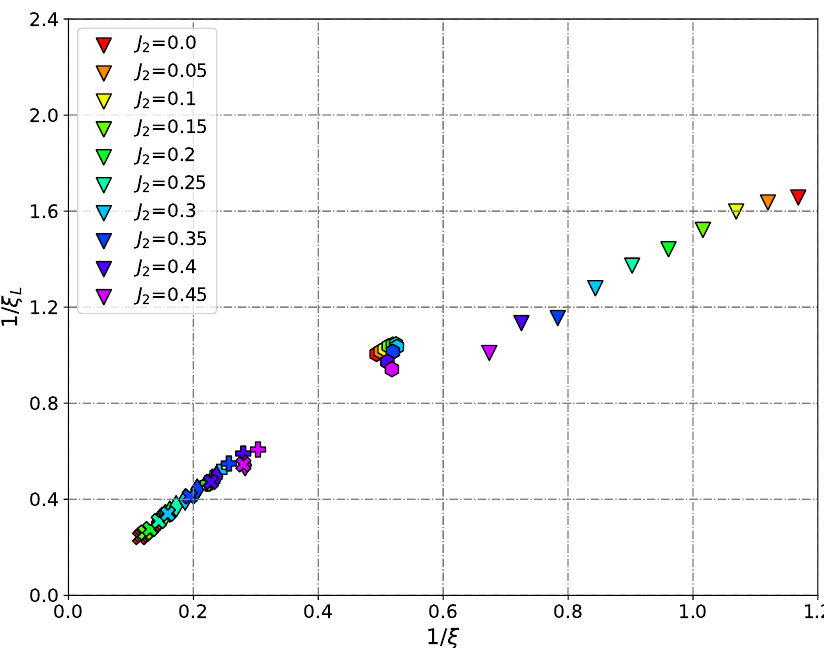
Figure 7: Longitudinal correlation length ξ tions, as a function of the transverse one ξ for different values of J (denoted by triangles, hexagons, pluses, diamonds, and crosses in the same